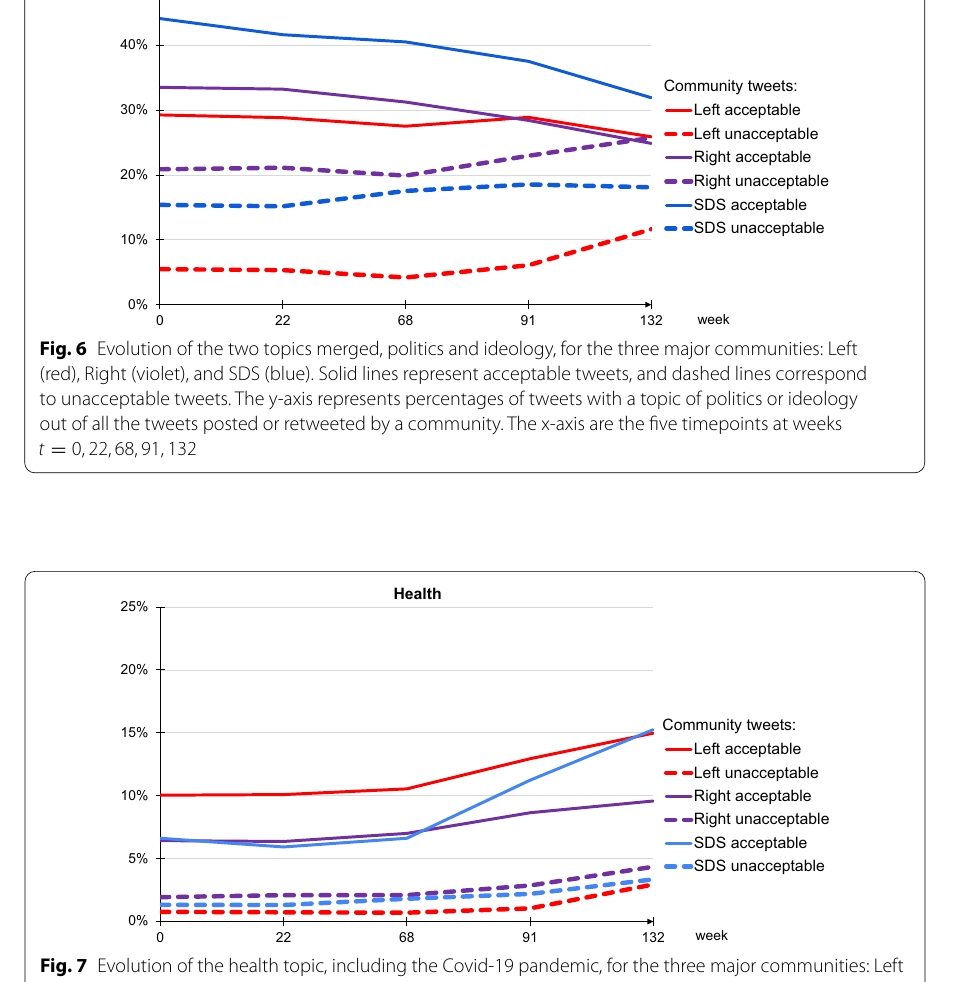
right-wing parties in the European Parliament (Cherepnalkoski et al. 2016), and the Leave proponents during the Brexit referendum (Grčar et al. 2017).